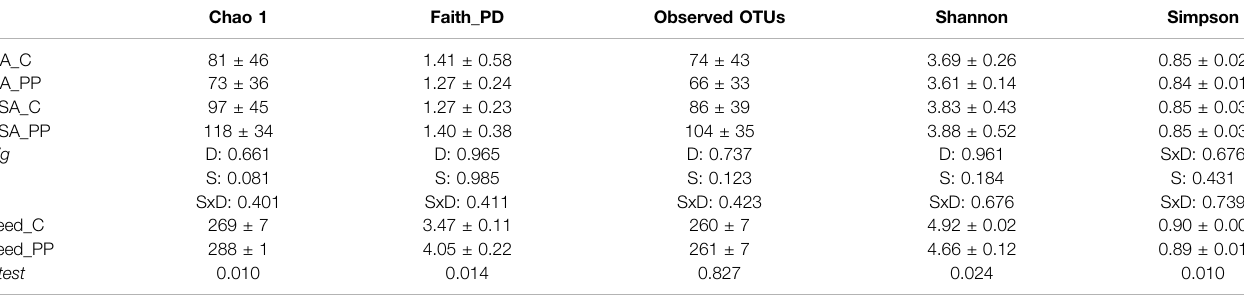
TABLE 4 | Alpha diversity indices (mean ± SD, rare fi ed at 17,778 reads) of microbial communities of feed ( n = 3) and gut mucosa ( n = 6) samples. diet, D; strain, S. Chao 1 Faith_PD